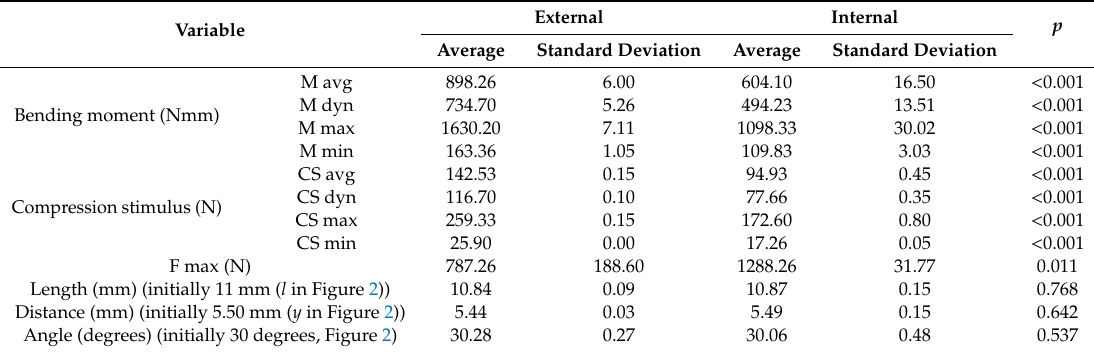
Table 3. Dynamic tests and dimensional characterisation results in both study groups (Mavg: mean bending moment in Nmm; Mdyn: half amplitude of the dynamic bending moment in Nmm; M: moment; CS: compression